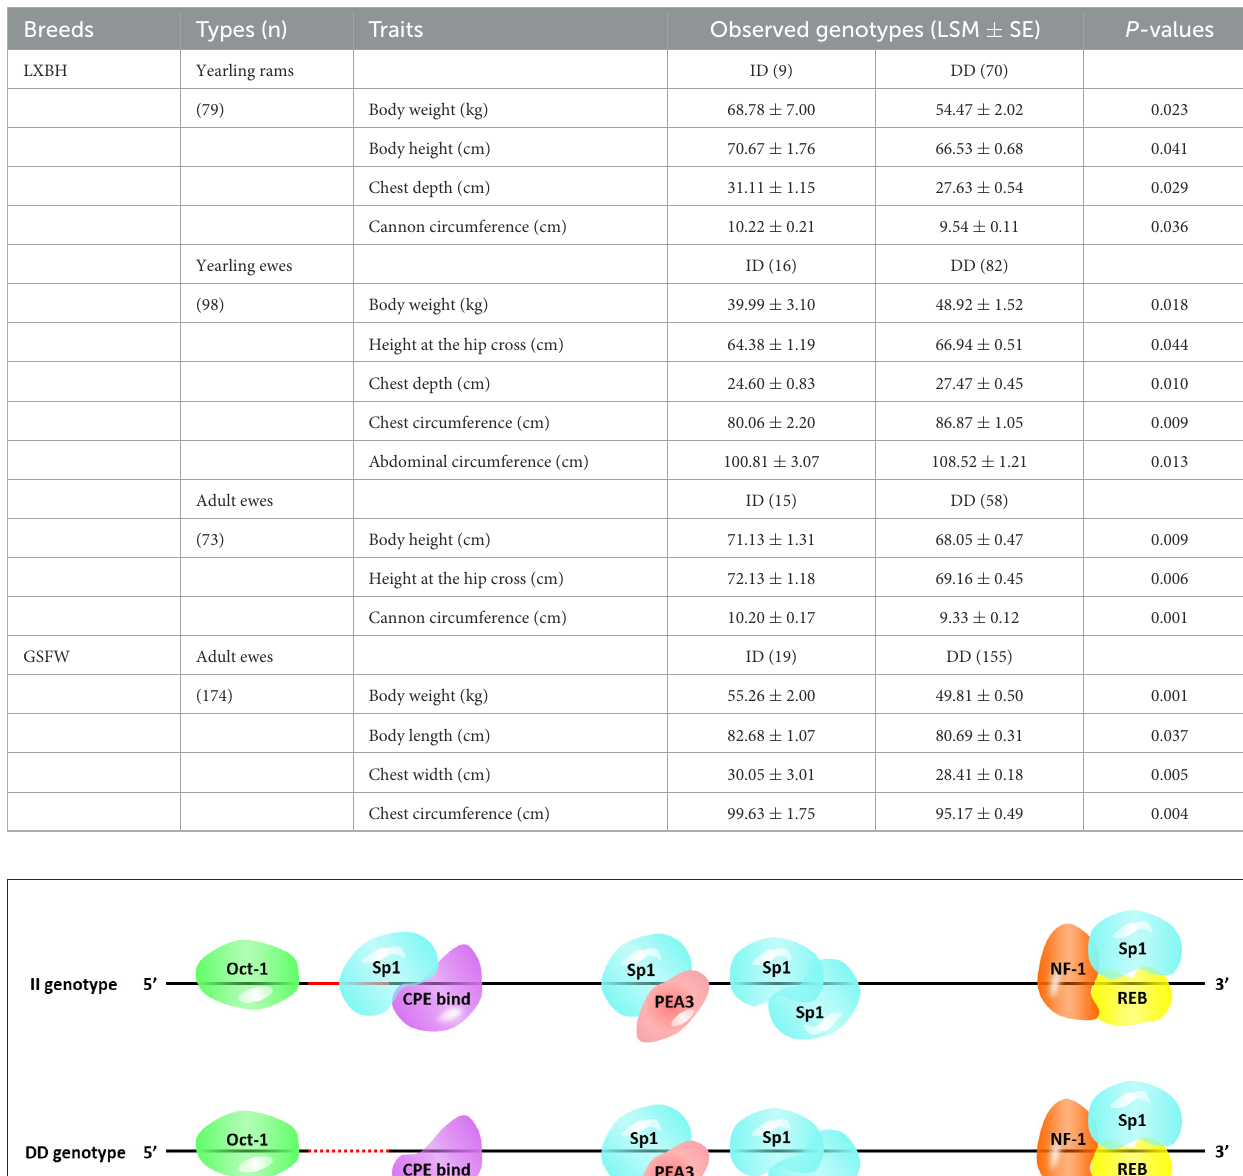
TABLE 4 Association between the HIAT1 P3-ins-9bp locus and sheep growth traits. Breeds